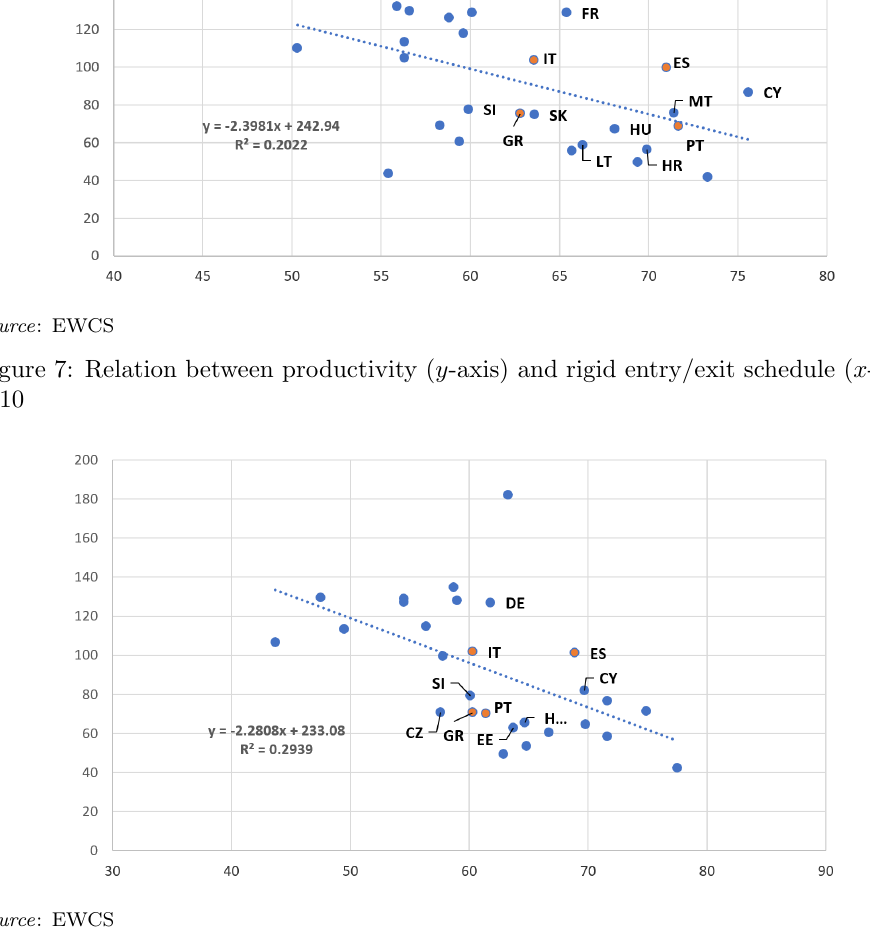
REGION : Volume 5, Number 3,